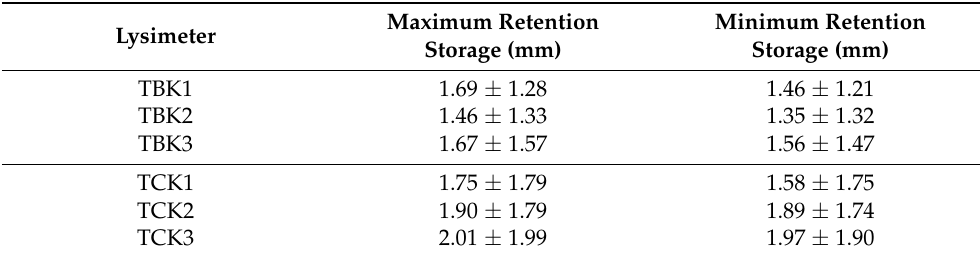
Table 3. Water retention in leaf litter per rainfall